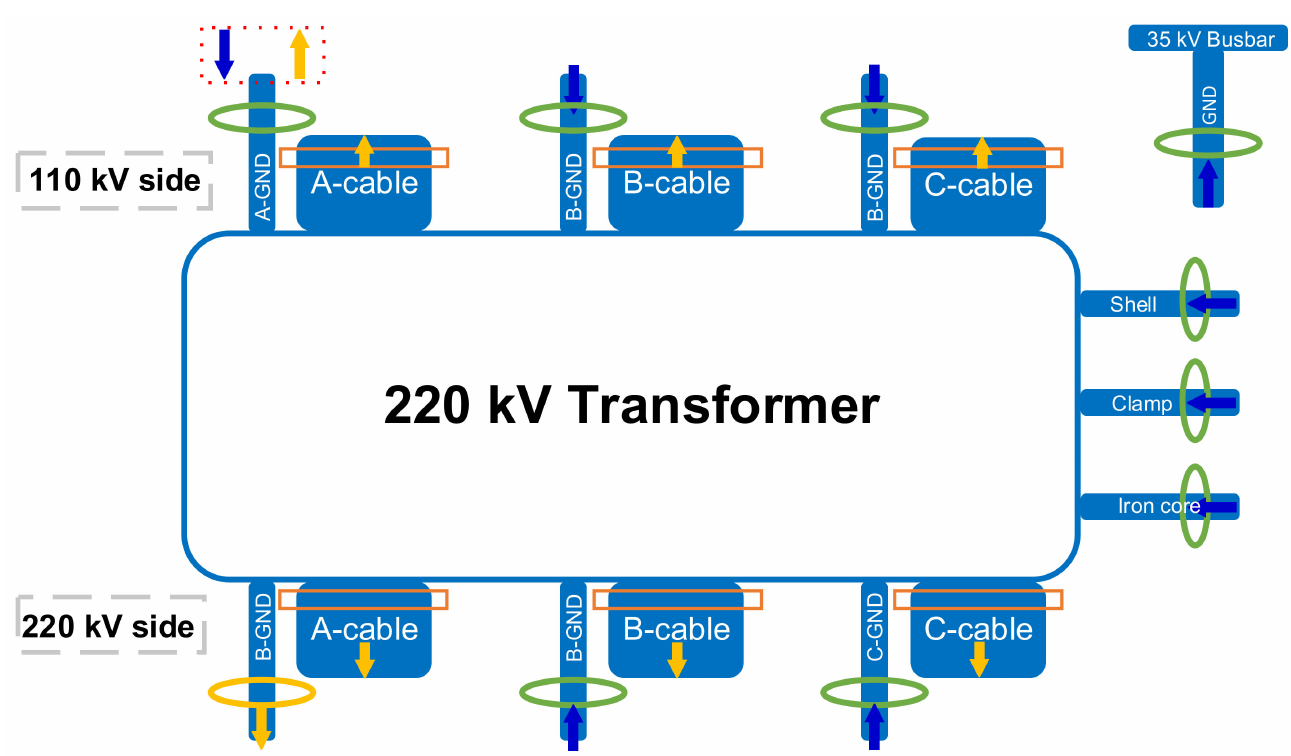
Figure 2. HF signal polarity diagram of oil–oil bushing transformer (220 kV C-phase cable terminal is the signal